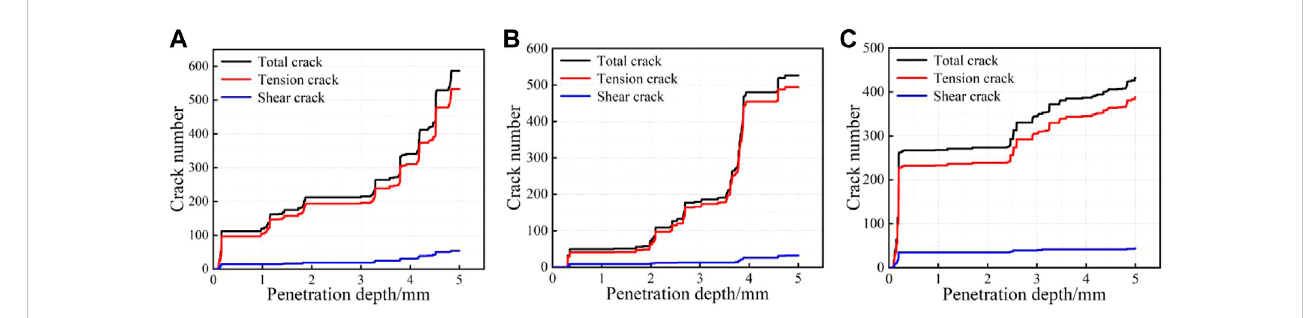
FIGURE 8 Micro-crack evolution curve (A) complete cutting model (B) same trajectory cutting model (C) different trajectory cutting model.